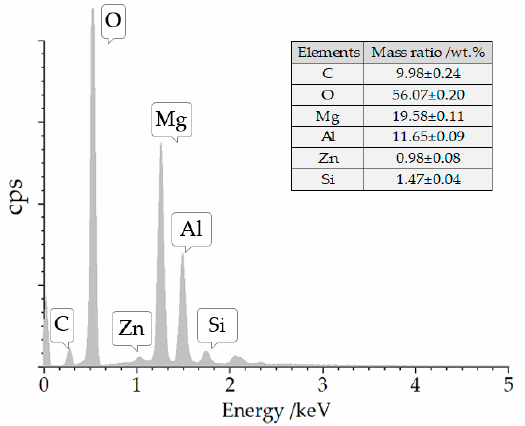
Figure 3. Energy-dispersive spectrometer (EDS) spectrum of LDHs.